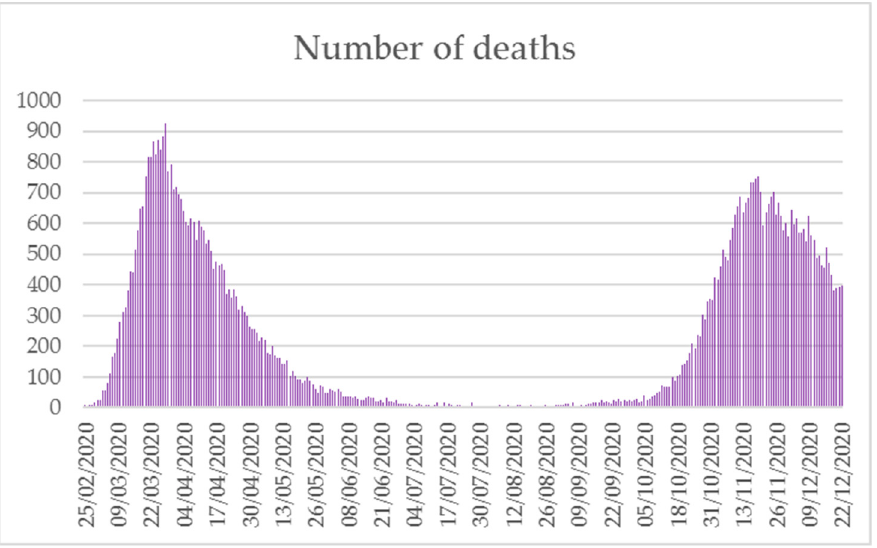
Figure 4. Daily deaths due to SARS-CoV-2, 21 February–22 December 2020 (modified from [40]). The lethality of the disease showed a relevant increase according to age, reaching the maximum in the ≥ 90 years age class (36.0% in males and 20.4% in females). Total lethality was 4.1% in men and 2.9% in females. Lethality was also higher in males of all age groups; the lethality value was close to 0 in both genders in the 0–29 years age group. As of 22 December 2020, the healed subjects were 1,151,639